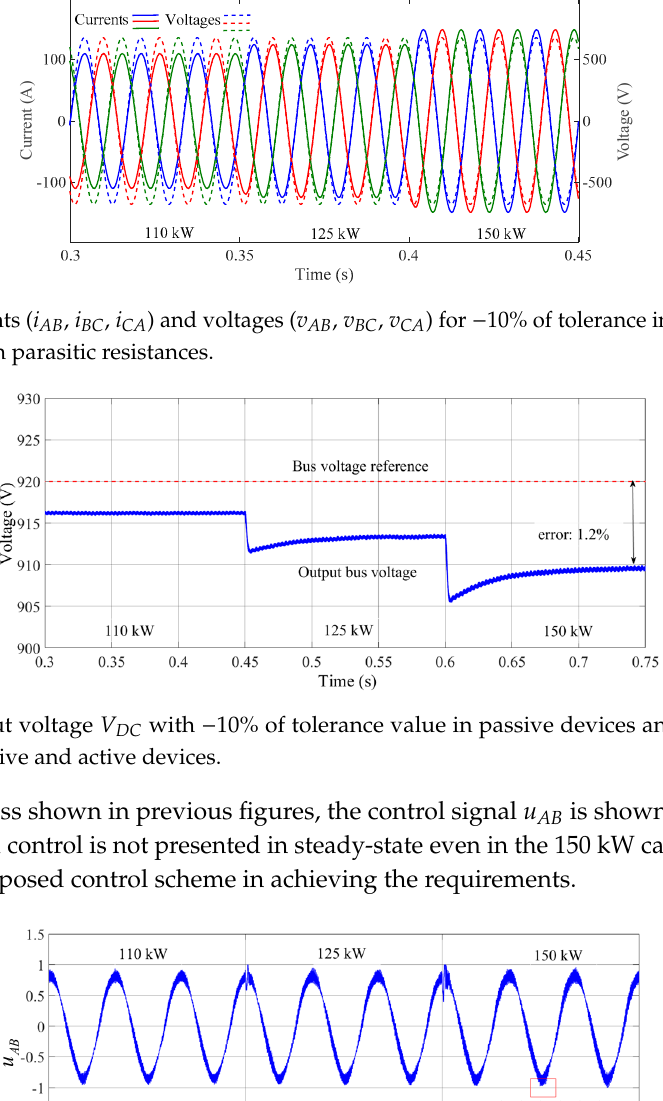
resistance in passive and active devices.